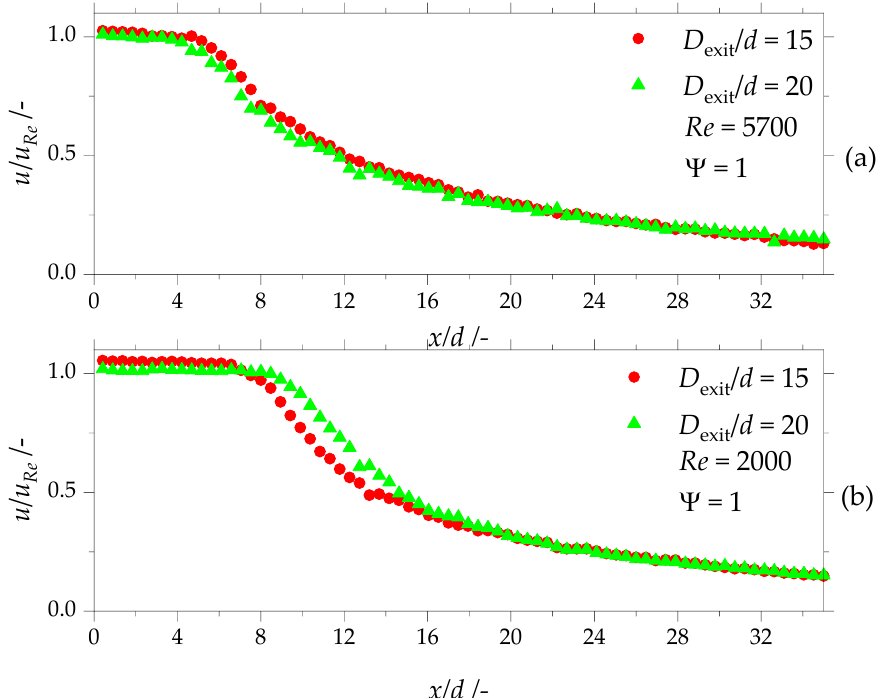
Figure 8. ( a ) Normalized velocity on the center axis of the original scale orifice ( Ψ = 1 ) with altered outlet channel diameter ratio at a Reynolds number Re = 5700; ( b ) normalized velocity on the center axis of the original scale orifice ( Ψ = 1 ) with altered outlet channel diameter ratio at a Reynolds number Re = 2000.